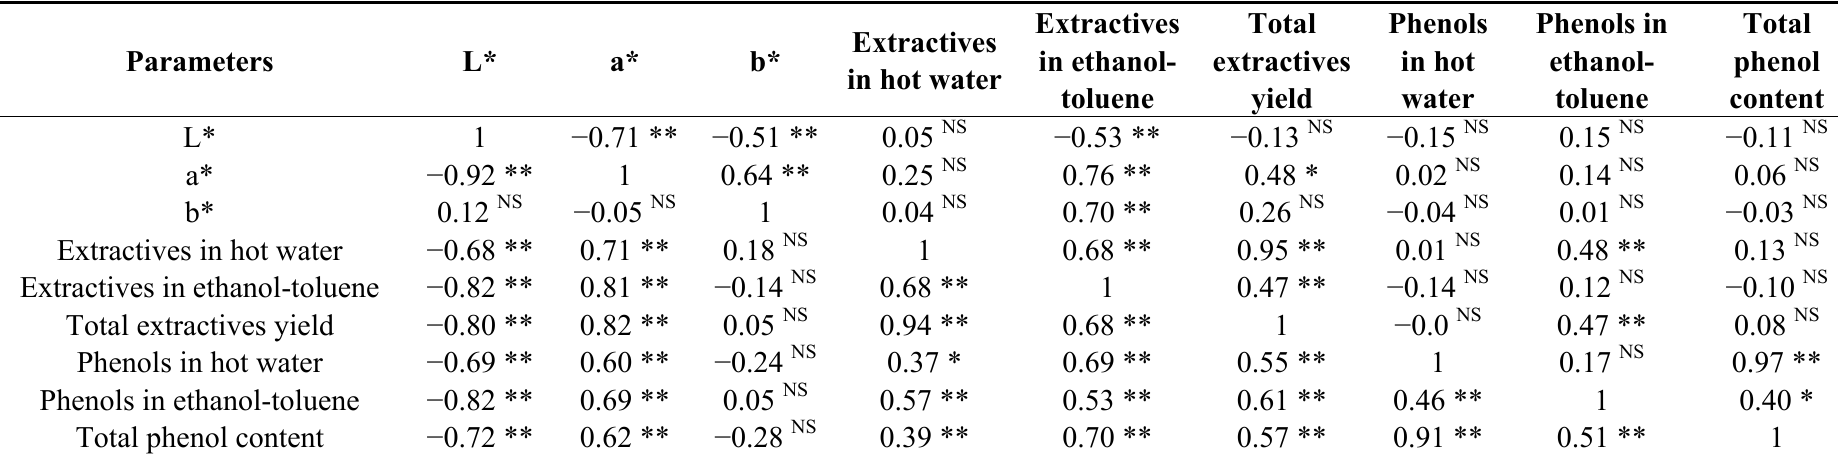
Table 3. Pearson’s correlation between wood color parameters and extractives content in V. guatemalensis (upper diagonal) and A. mangium (lower diagonal), considering sapwood and heartwood samples